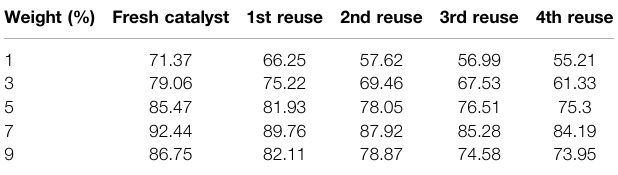
TABLE 9 | Reusability study of sulfonated MFL seed shell catalyst